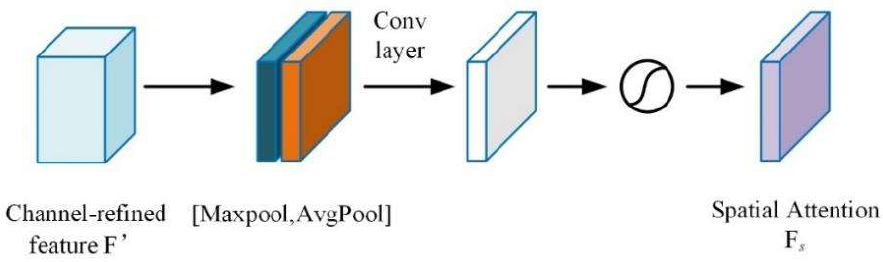
Figure 7. Schematic diagram of the structure of the spatial attention model.